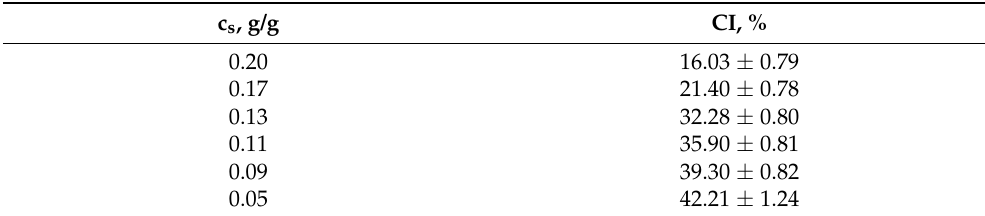
Table 2. The CI (%) values in the starch–fat emulsions at different starch concentrations (g/g) in the systems. The values are expressed as means ± SD ( n =